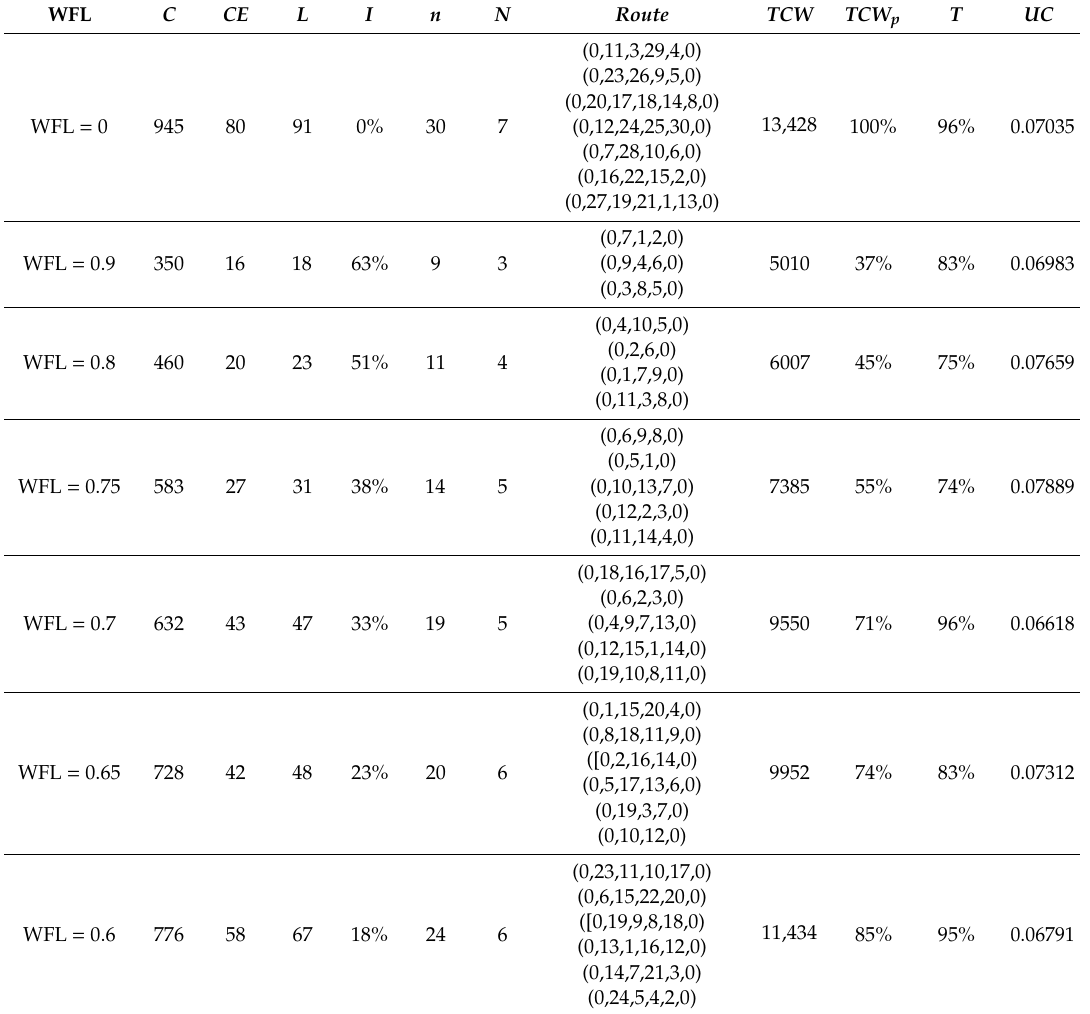
Table 9. Obtained detailed results by applying the WFL